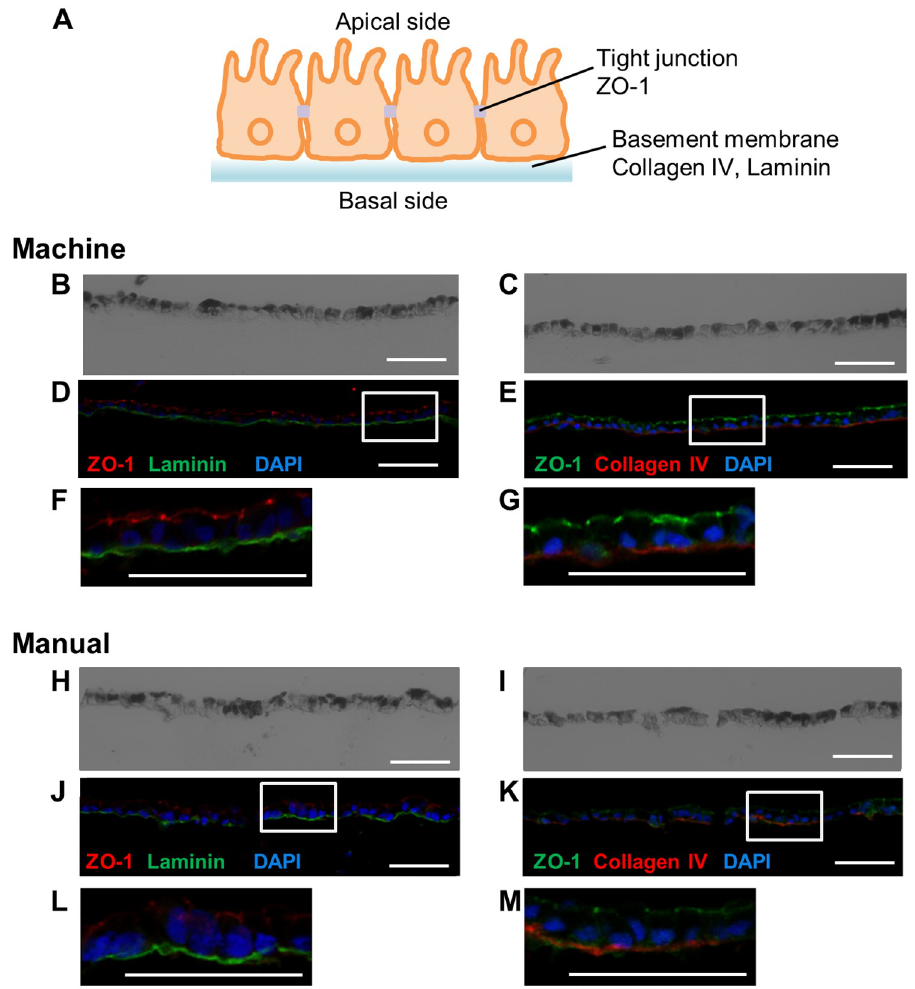
Fig 1. Phase-contrast and fluorescence images of immunostaining. hiPS-RPE cell sheets were cultured for 49 days using both machine and manual culture methods. (A) Schematic figure showing a cross-section of the RPE cell sheet. (B–G) Phase-contrast (B, C) and fluorescence (D–G) images of machine-cultured hiPS-RPE cell sheets. (B, D, F) Immunostaining for tight junction (ZO-1, red) and basement membrane (laminin, green) proteins. (C, E, G) Immunostaining for tight junction (ZO-1, green) and basement membrane (type IV collagen, red) proteins. (H–M) Phase-contrast (H, I) and fluorescence (J–M) images of manually cultured hiPS-RPE cell sheets. (H, J, L) Immunostaining for tight junction (ZO-1, red) and basement membrane (laminin, green) proteins. (I, K, M) Immunostaining for tight junction (ZO-1, green) and basement membrane (type IV collagen, red) proteins. Scale bars: 50 μ